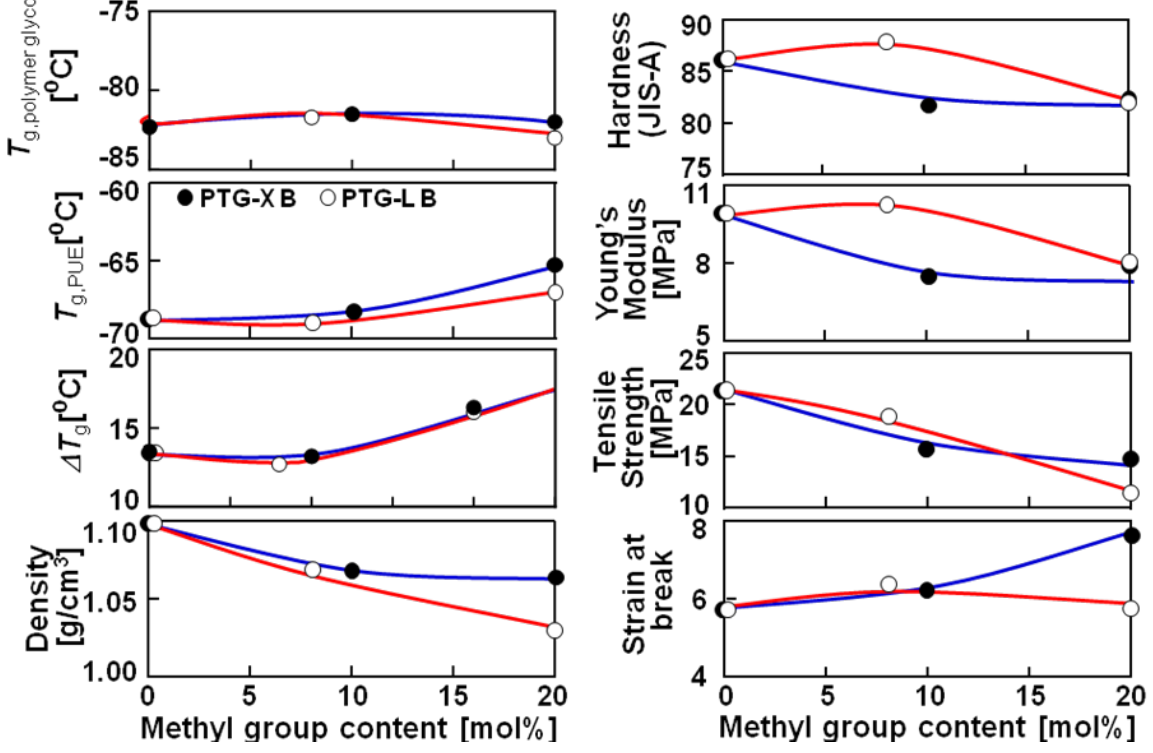
, density, hardness and g